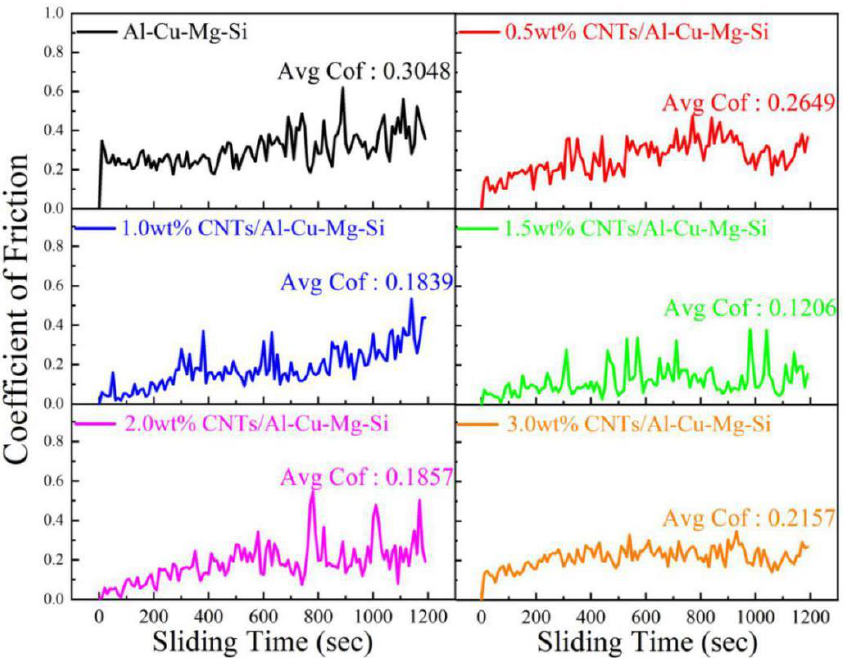
Figure 13. Plot of the coefficient of friction as a function of sliding time for x % CNTs /Al-Cu-Mg-Si composites under 200 °C.